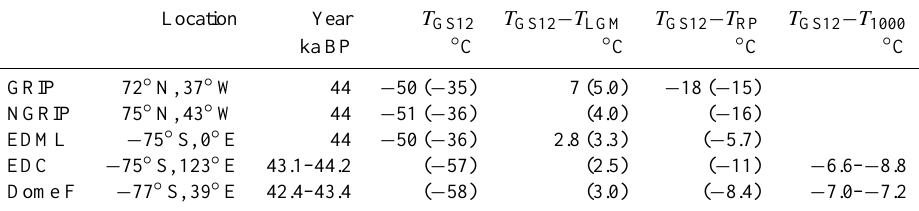
Table 2. Reconstructed temperature from δ 18 O from Greenland and Antarctic ice cores (Johnsen et al., 2001; EPICA Community Members, 2006; Jouzel et al., 2007; Kawamura et al., 2007) and from δ 15 N from a Greenland ice core (Huber et al., 2006). The simulated annual mean T 2m at the closest grid point is given in parentheses for each location. The EDC and Dome F data are given as a difference between GS12 and the last 1000